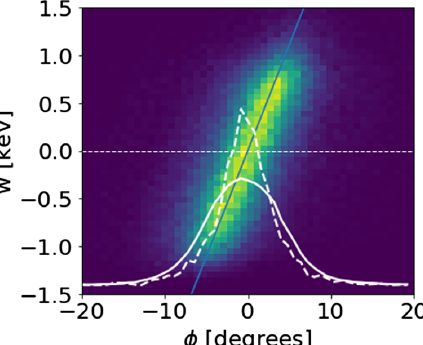
FIG. 17. f ð ϕ ; w Þ phase space immediately after selection at the energy slit. The solid white line plots the projected phase distribution f ð ϕ Þ . The dashed line shows the partial phase ˆ f ð ϕ Þj distribution w ¼ 0 (along the thin horizontal dashed line). This distribution is generated through P y ORBIT simulation.